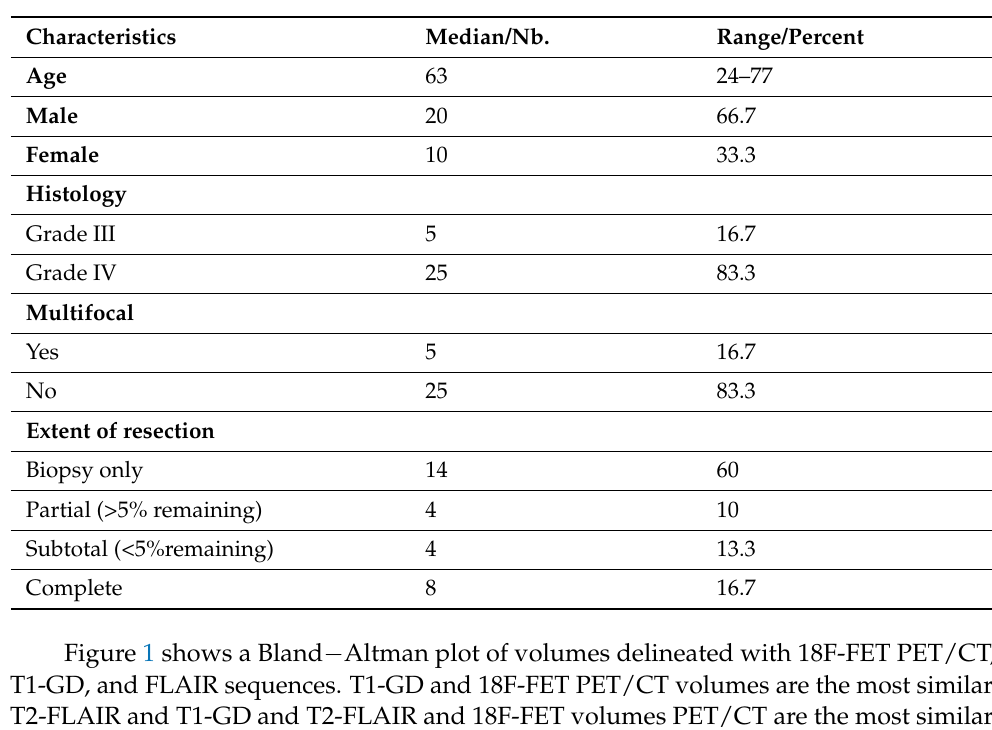
Table 1. Patient and tumor characteristics.